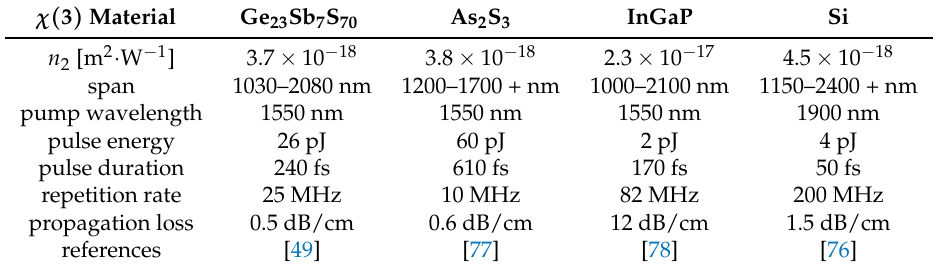
Table 3. On-chip supercontinuum. The n 2 for Ge 23 Sb 7 S 70 and InGaP are inferred indirectly through measurement of γ coefficient in waveguides. For SiN, AlN, and LiNbO 3 refer to Table 1 with CEO detection